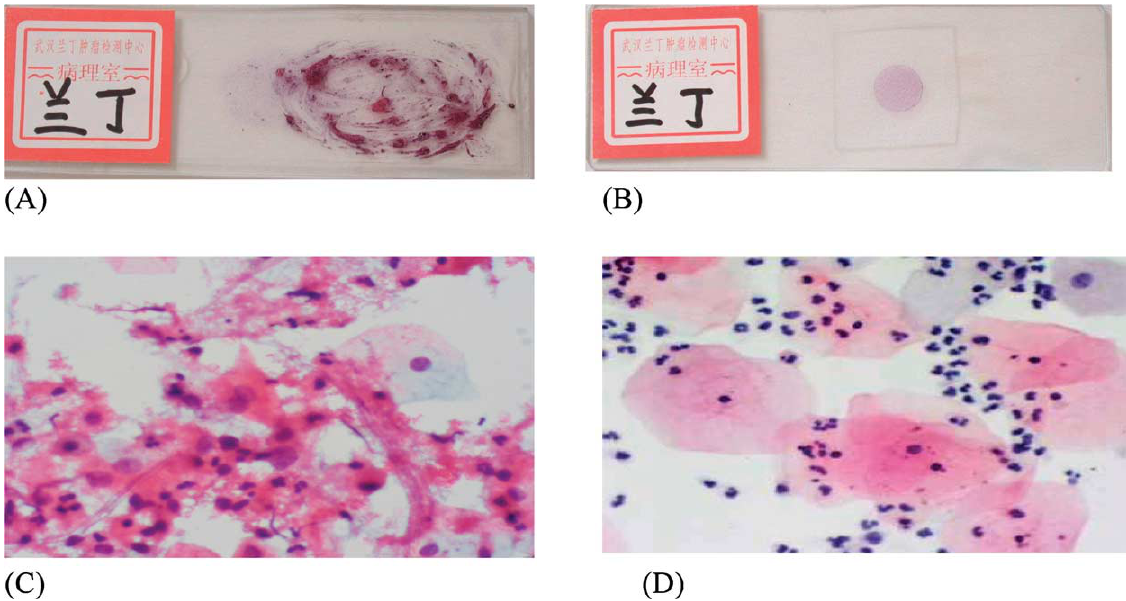
Fig. 3. Comparison of conventional Pap smear to liquid-based preparation. (A) Conventional smear slide. (B) Liquid-based preparation slide. (C) Overlapping and unevenly distributed cells of the convention slide in (A) above (Papanicolaou staining, × 200). (D) Monolayer epithelial cells evenly dispersed of the liquid-based preparation slide in B above (Papanicolaou staining, × 200).